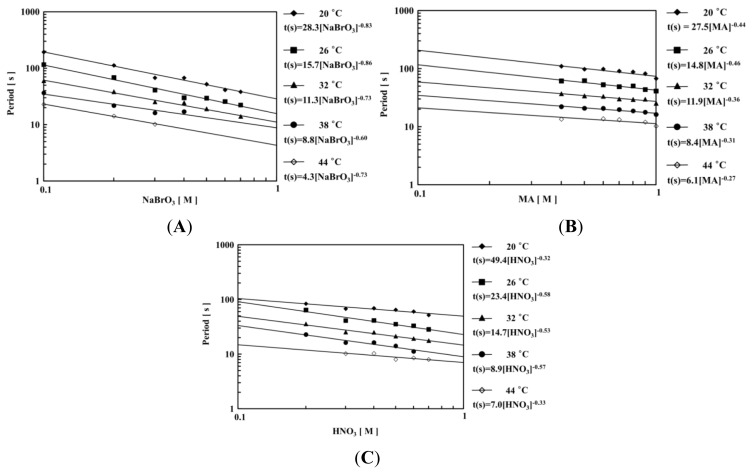
The dependence of the period as a function of temperatures (20–44 °C) and the one BZ substrate under the fixed condition of of (A) [MA] = 0.1 M, [HNO3] = 0.3 M; (B) [NaBrO3] = 0.3 M, [HNO3] = 0.3 M; (C) [NaBrO3] = 0.3 M, [MA] = 0.1 M.